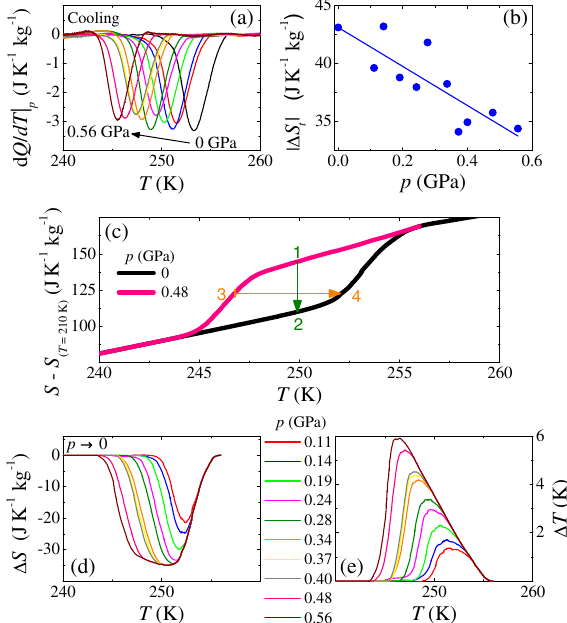
FIG. 3. (a) Temperature-dependent heat flow under pressure on cooling through the transition at different ½ð dQ Þ = ð dT Þ(cid:2)j p values of increasing pressure p after baseline subtraction. The full legend is the same as in (d) and (e). (b) Entropy changes cooling through T obtained from the data in (a). (c) Isobaric entropy N curves S − S 210 on cooling at 0- and 0.48-GPa applied pressure. K The green arrow from 1 to 2 and orange arrow from 3 to 4 indicate the isothermal entropy and adiabatic temperature changes, respectively, upon removal of pressure. (d),(e) Isothermal entropy N and adiabatic temperature changes obtained from the data in (a) as explained in